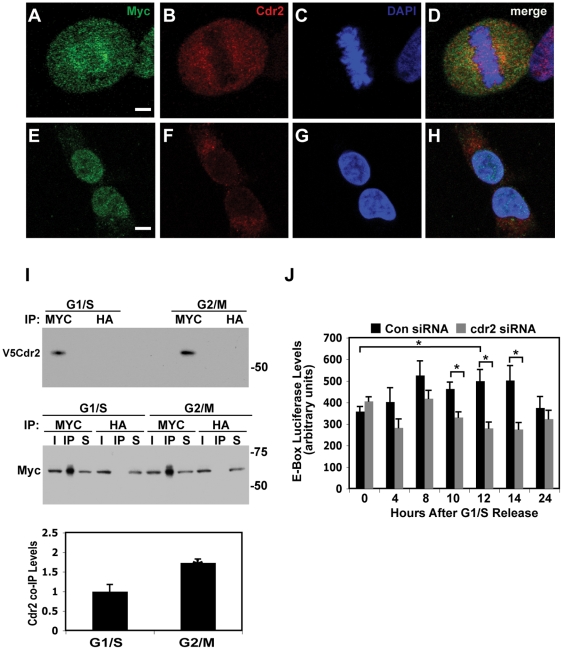
Cdr2 interacts with and regulates c-myc during mitosis.High power (63X), thin section confocal images of HeLa cells stained with anti-c-myc (9402; A, E), anti-Cdr2 (4F5; B, F), DAPI (C, G) and merged images (D, H); Scale bar = 20 µm. I. Immunoprecipitation of G1/S and G2/M-arrested V5cdr2 and c-myc transfected HeLa extracts with anti-c-myc (C3956) and control anti-HA, blotted with anti-V5 to detect co-immunoprecipitated V5cdr2. Middle, control anti-c-myc (9E10) western of above inputs, immunoprecipitates and supernatants. Bottom, quantitation of V5cdr2 co-precipitated by anti-c-myc, normalized to V5cdr2 input (data not shown); *p<0.01. J. Luciferase assay of G1/S released HeLa extracts transfected with c-myc responsive E-box luciferase and cdr2 or control siRNA pools; *p<0.05.